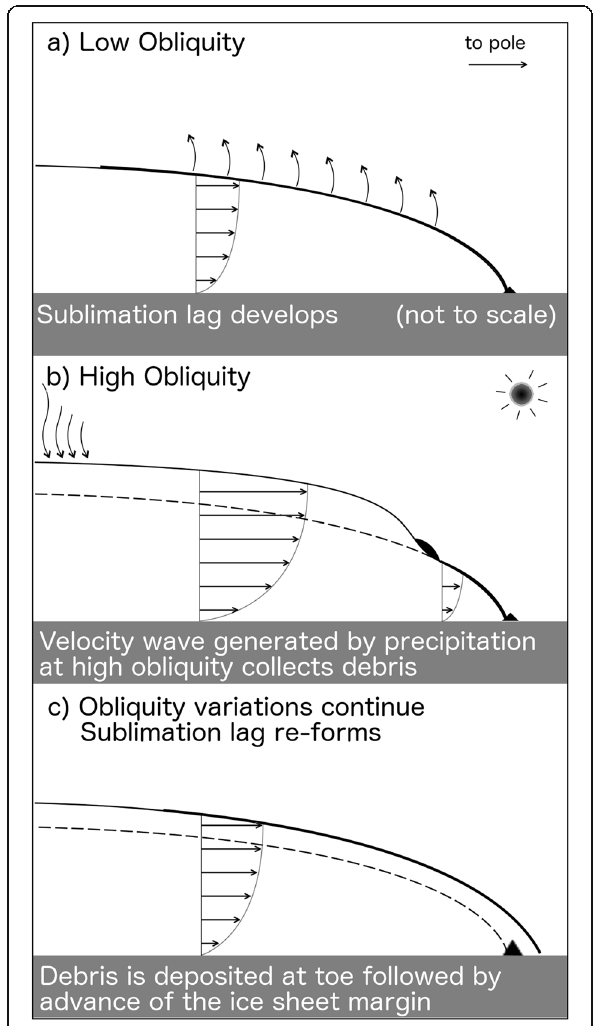
Fig. 14 Sketch of proposed mechanism for ridge deposition. a Sublimation lag develops on surface of ice sheet. b Ice accumulation on the flanks of Pavonis produces a velocity wave which collects surface debris. c Debris is deposited at the ice margin and subsequently overridden by the advancing ice